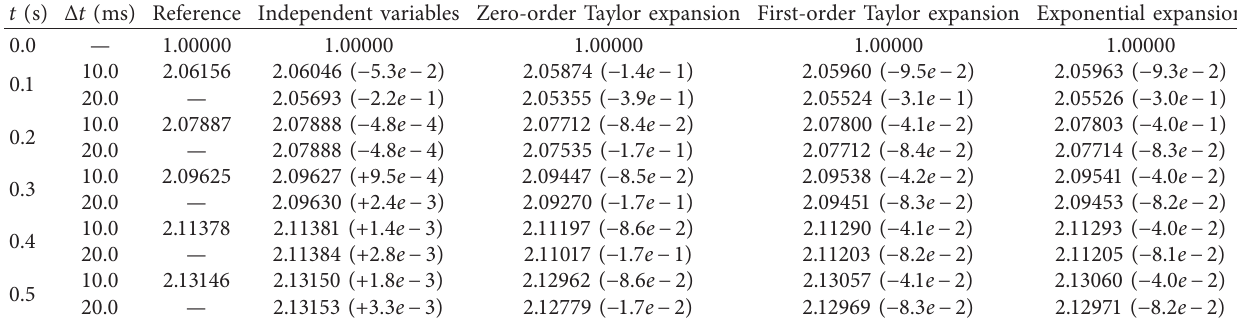
Table 2: Comparison of relative power (percentage error) between independent precursor methods and precursor integral methods for step reactivity insertion.